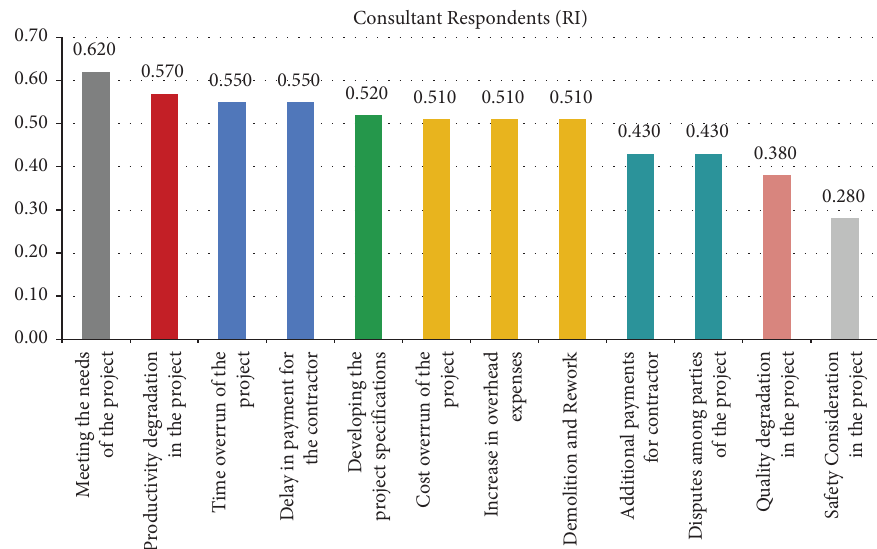
Figure 2: Frequency of impact of change orders on projects (consultants’